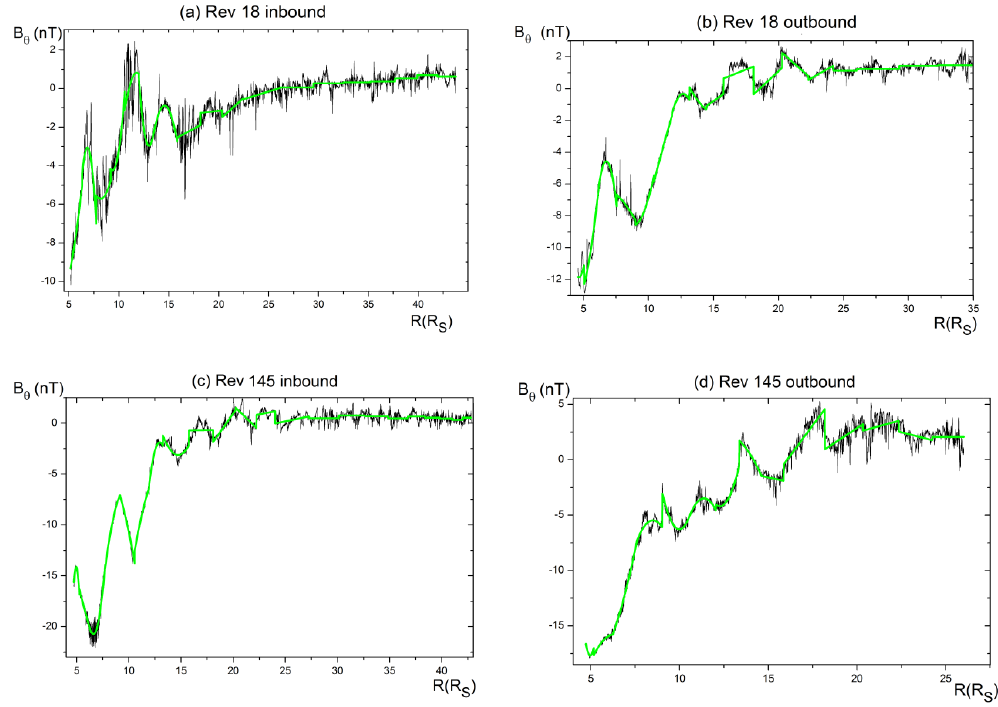
Figure 4. Illustration using data from the inbound and outbound passes of Revs 18 and 145 of the calculation of the “smooth fitted” field profiles described in Sect. 4, used to evaluate the errors between the field profiles and the “selected” parameter and “linear approximation” model field profiles. The black lines show the observed field values as in Fig. 3, while the green lines show the smooth fitted profiles.